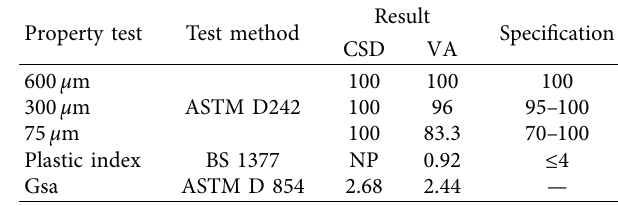
Table 1: Bitumen quality test results.